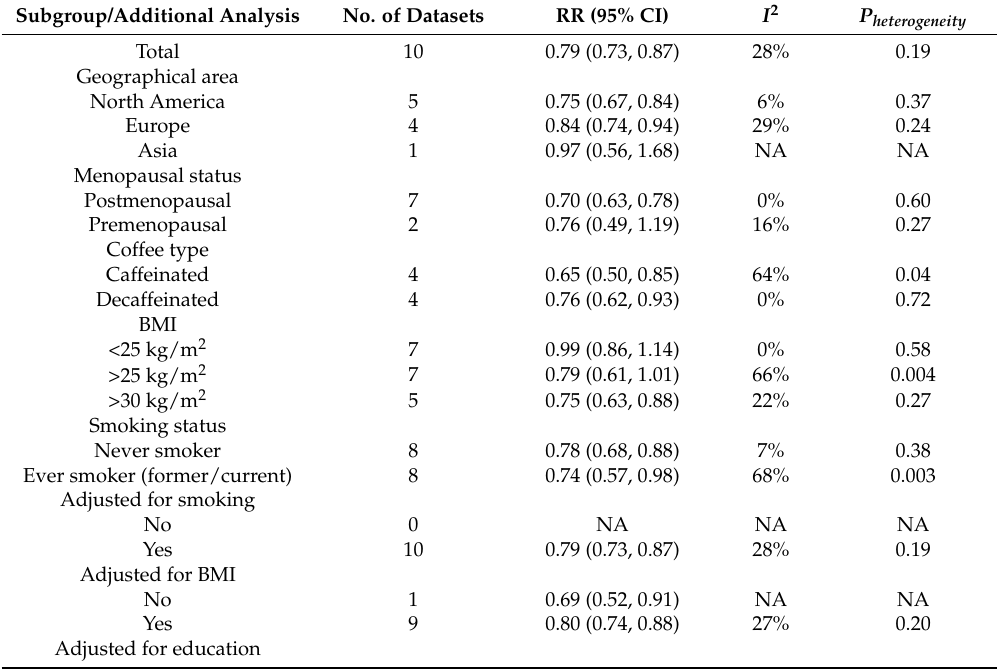
Table 2. Subgroups and additional analyses of studies reporting the risk of endometrial cancer for the highest versus the lowest (reference) category of coffee consumption (analyses based on 12 studies consisting of 10 databases).